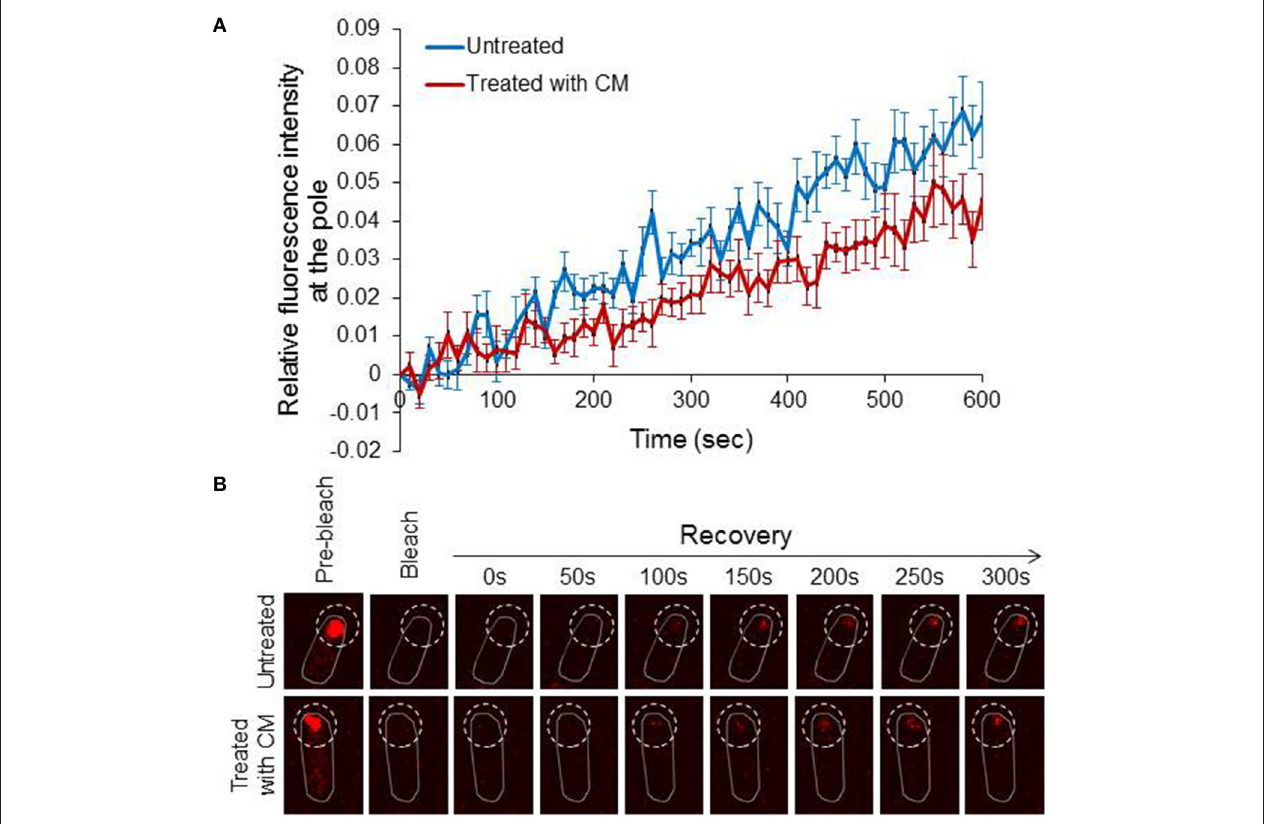
FIGURE 3 | Diffuse EI molecules dynamically incorporate into polar clusters (A) Line chart showing the recovery of EI-mCherry fluorescence signal in untreated cells (blue) ( n = 14) or in chloramphenicol-treated cells (red) ( n = 12) from the time of bleaching (time 0) over 600s. Mean and standard error are shown. (B) Representative FRAP microscopy images of wild-type E. coli cells expressing EI-mCherry in the absence of treatment (upper panel) or in the presence of chloramphenicol (lower panel). Images at selective time points are shown. The contour of the bleached area in the fluorescent images is